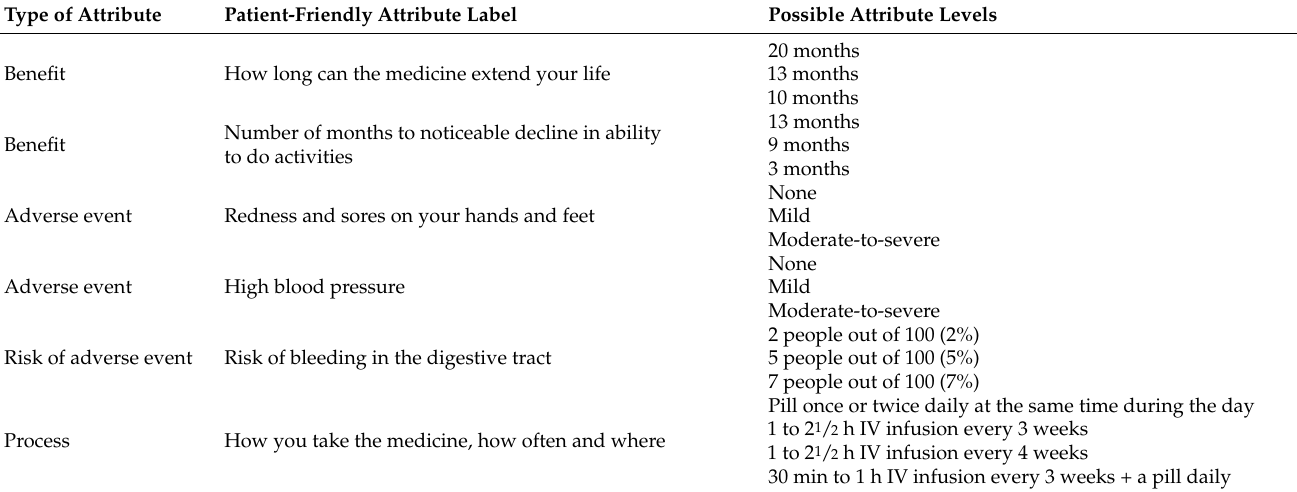
Table 1. Attributes and levels for the discrete-choice experiment